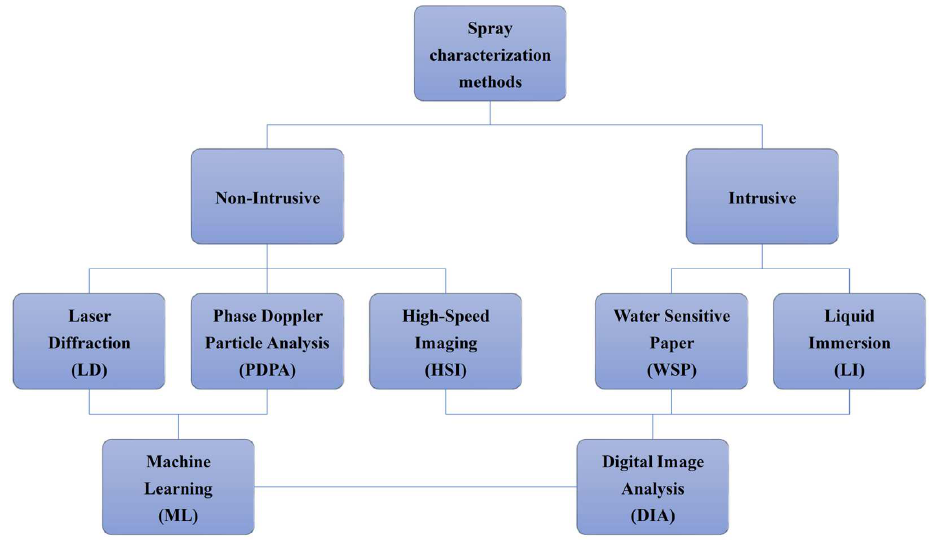
Figure 1. Scheme of the main spray characterization methods. Table 2. Systematization of cited bibliographic references according to the drop size measurement method treated.